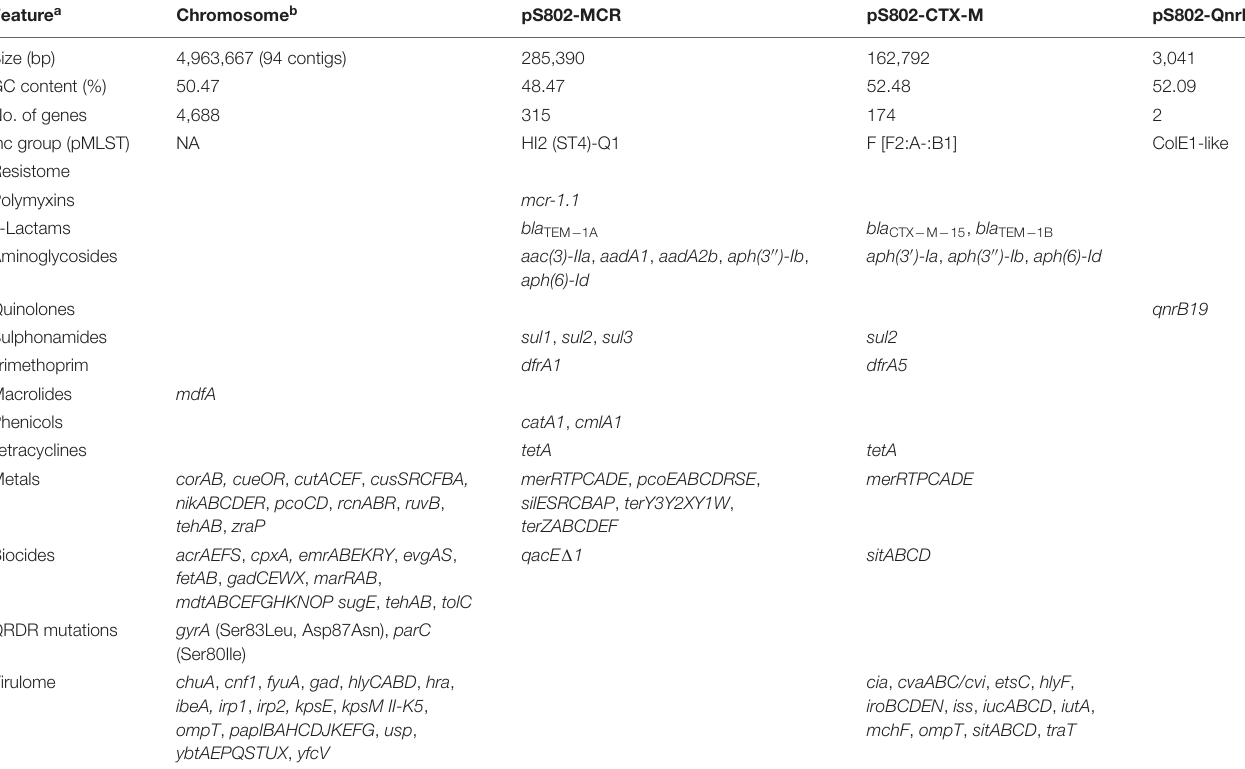
TABLE 2 | Genome features, resistome, and virulome of E. coli